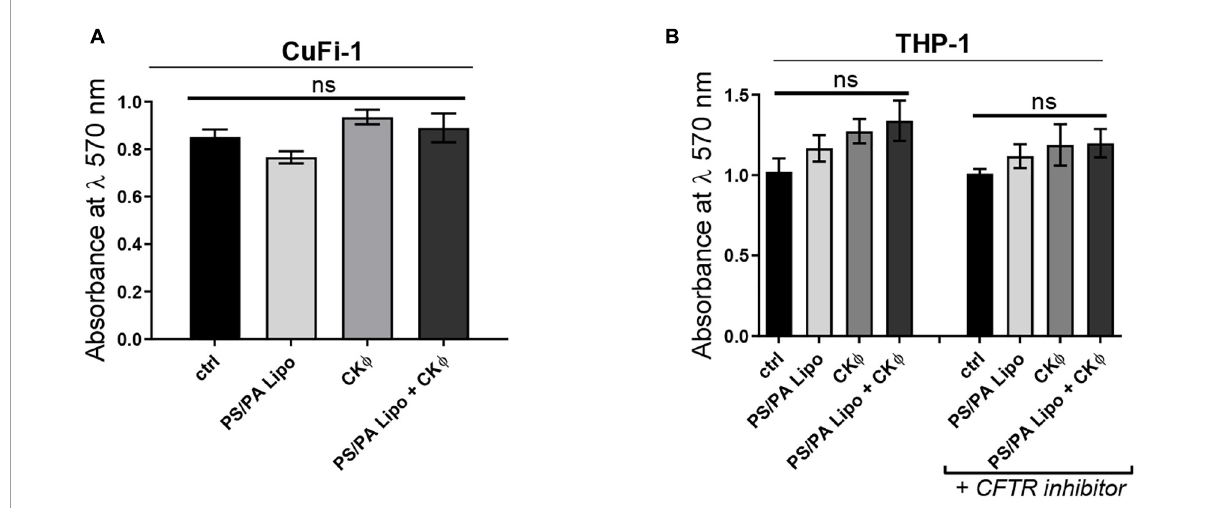
FIGURE5 PS/PA liposomes and CK (cid:56) administration does not elicit toxic effects on human CF cells. (A) Cell viability, evaluated by MTT assay, in immortalized human bronchial epithelial cells CuFi-1 expressing F508del CFTR control, treated with phosphatidylserine/phosphatidic acid (PS/PA) liposome, CK (cid:56) or combination of PS/PA liposome-CK (cid:56) for 48 h. (B) Cell viability, evaluated by MTT assay, in THP-1 activated macrophage-like cells treated or not with the CFTR inhibitor. Effects of single or combined PS/PA liposome and CK (cid:56) -administration were evaluated after 48 h of treatment. Unpaired Student’s t test: * p < 0.05; ns, not significant. Results are presented as mean ±